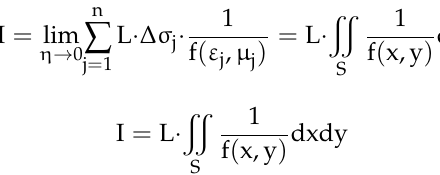
(cid:113) ε j2 + µ j2 ) and L is the measured radiance of the target radiation where f ( ε j , µ j ) = f (